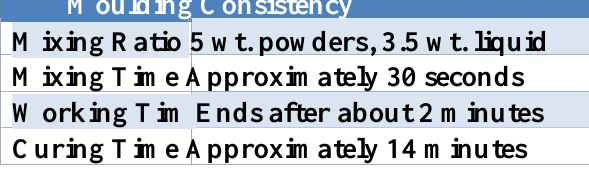
Table, 1: Technical information of acrylic bone cement according to the product company.